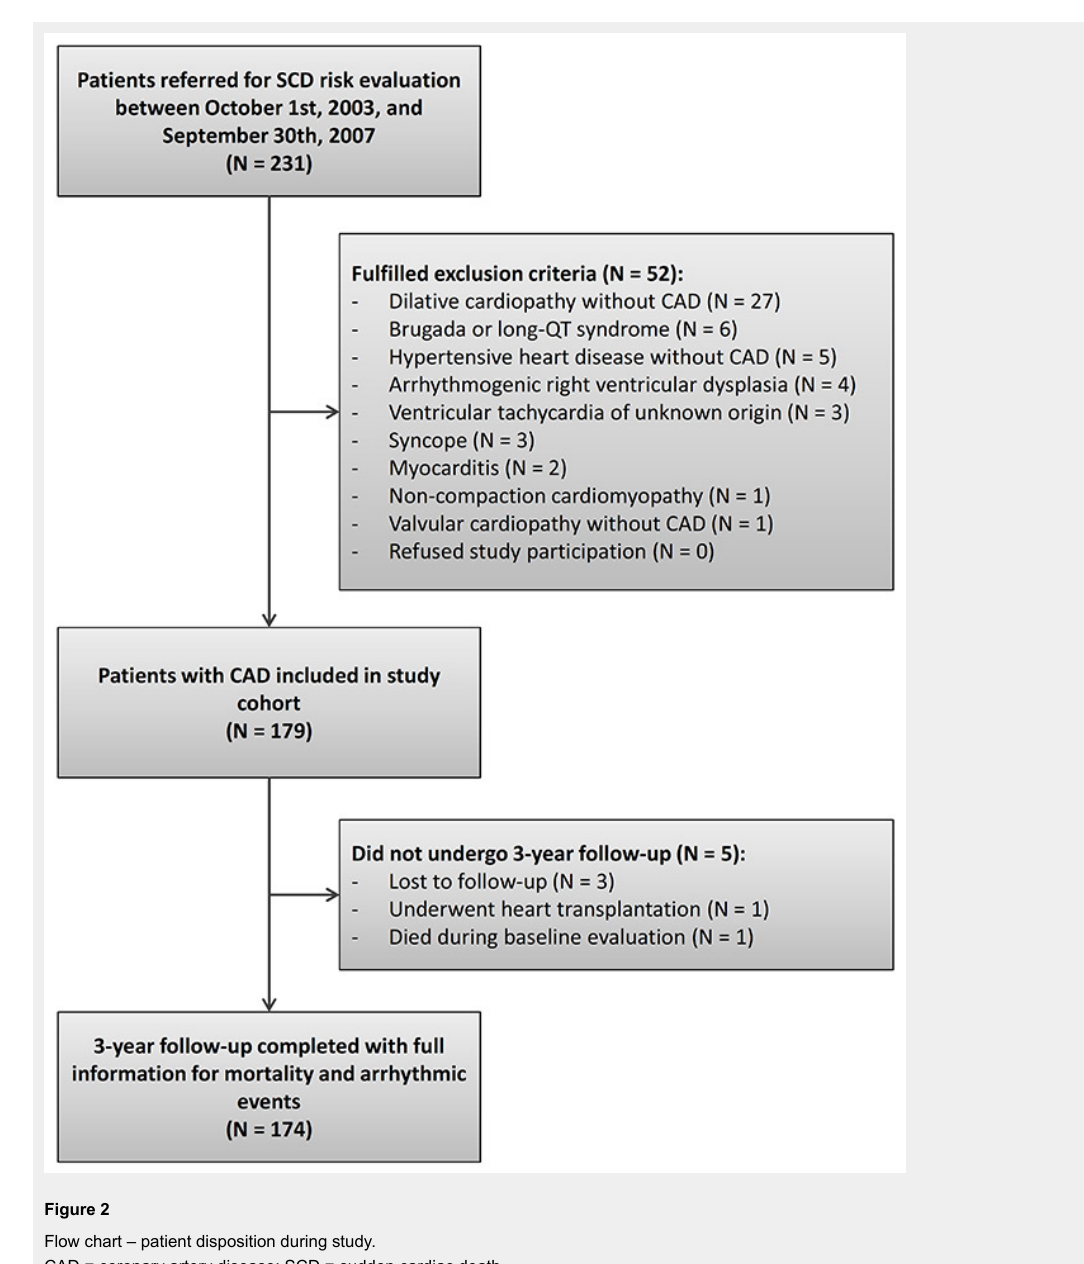
Figure 2 Flow chart – patient disposition during study. CAD = coronary artery disease; SCD = sudden cardiac